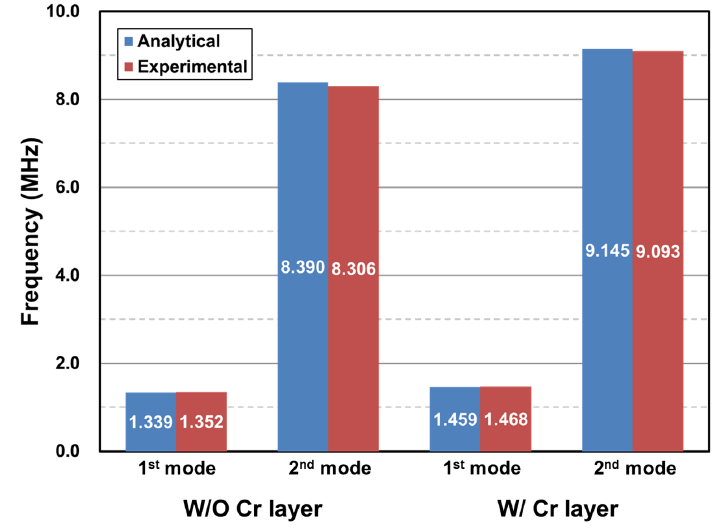
Figure 8. A comparison of resonant frequencies obtained from the experiment and the theory. Table 1. Material properties used in the analytical estimation.